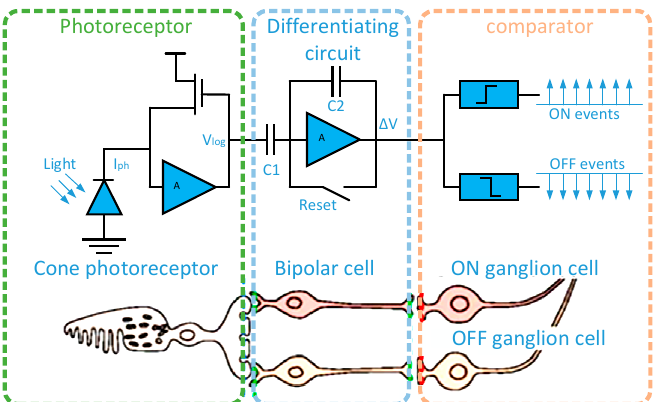
Figure 1. Three-layer model of a human retina and corresponding event camera pixel circuitry. The first layer is similar to retinal cone cells for photoelectric conversion; the second layer, similar to bipolar cells in the retina, is used to obtain changes in light intensity; the third layer is similar to the ganglion cells of the retina for outputting the light intensity change sign.